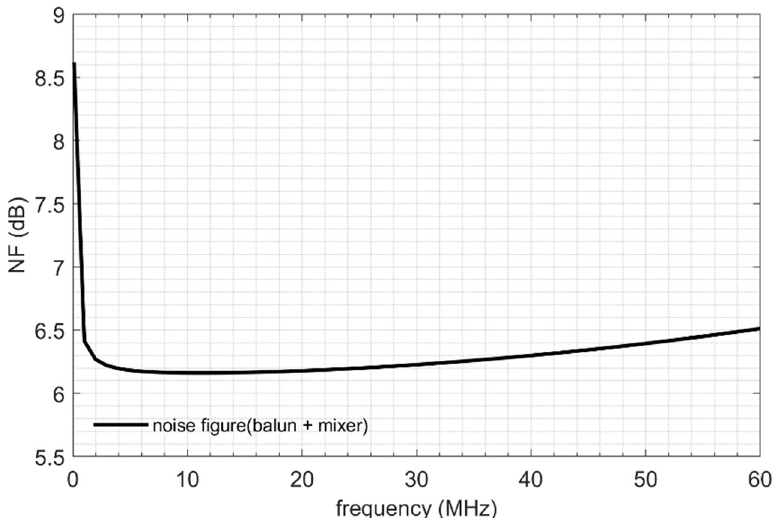
Figure 18. Dsb noise figure of the balun and mixer.